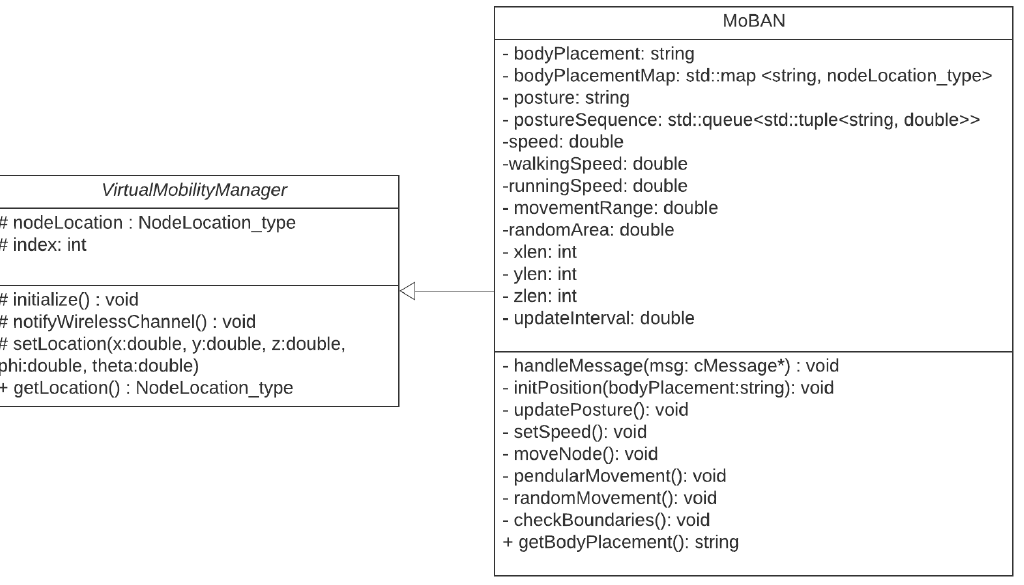
Figure 4. Class diagram of the mobility model implemented in the BNS framework. Therefore, two timers are used, one scheduled at each updateInterval to update the node position, which when triggered calls the method moveNode() , notifies the wireless channel, schedules the next update; while the other timer is used for posture update, responsible for changing the posture string, updating the node speed and scheduling a new timer for the next posture change. The moveNode() procedure checks the posture and position of the nodes and calls the specific movement functions for it. The implementation in the BNS framework follows Algorithm 1. In this way, each node performs only the movements necessary for its position in the given posture. PendularMovement makes pen- dular movements around the node’s initial location in a range defined by movementRange() , randomMovement() performs random movement within a radius defined by randomArea in around the current location of the node and checkBoundaries checks whether, after the movements, the nodes have exceeded the simulation area, limiting the movement to the threshold of the simulation